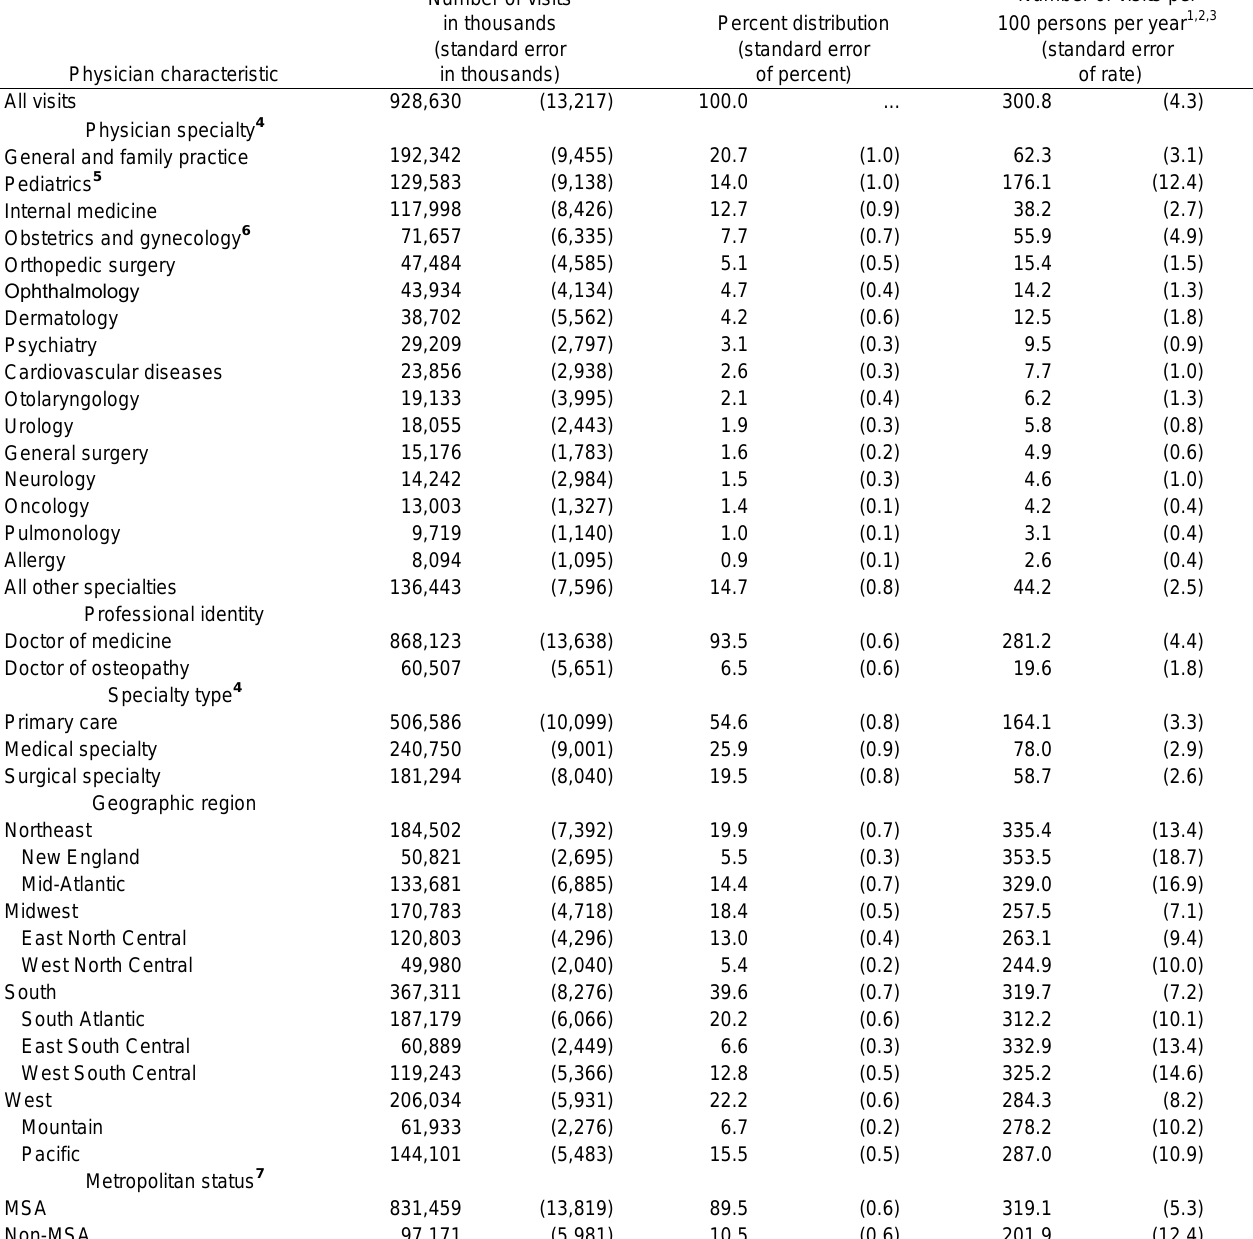
Table 1. Physician office visits, by selected physician characteristics: United States,